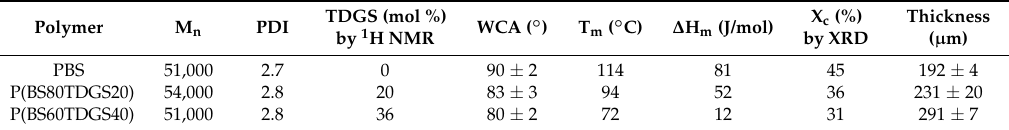
Table 1. Characterization data of the neat polymers (from [11]).